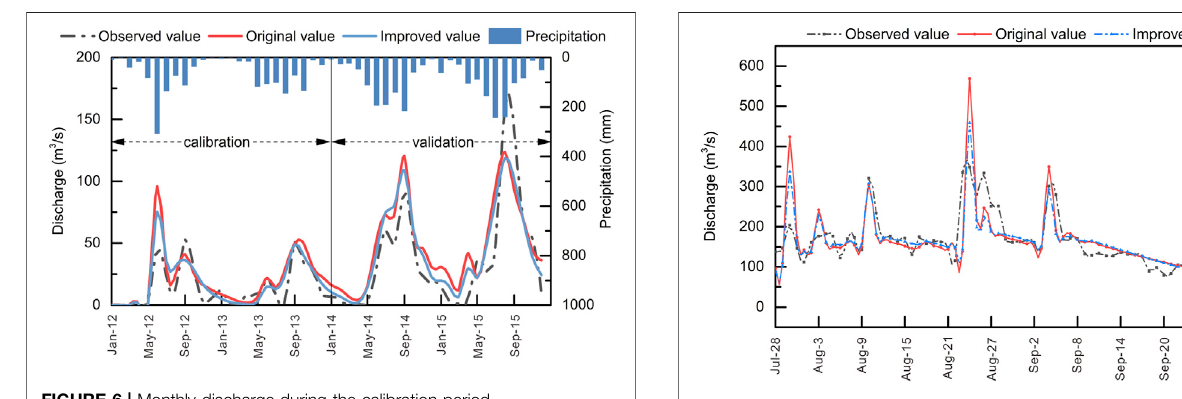
FIGURE 6 | Monthly discharge during the calibration period (2012 – 2013) and the validation period (2014 – 2015) before and after model improvement.